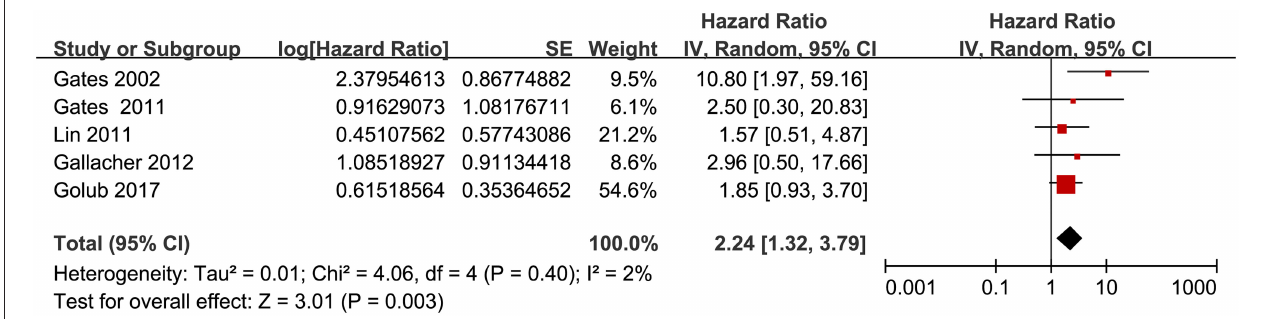
FIGURE 5 | Forest plots for the meta-analysis concerning the association between hearing loss and the subsequent incidence of Alzheimer’s disease (AD). to 1.72, p < 0.001, I 2 = 89%). The funnel plots for the